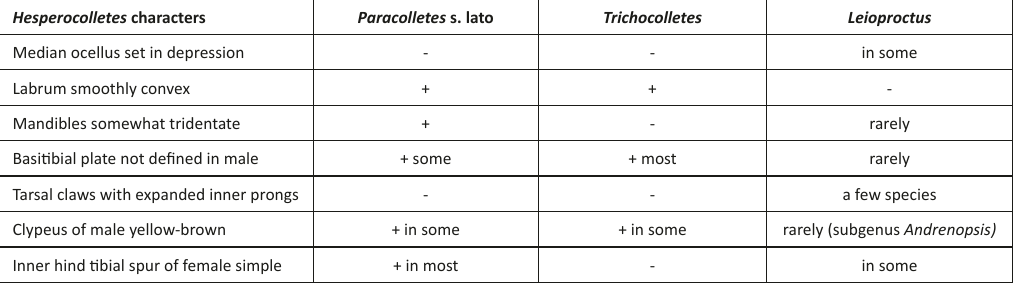
Table 1. Character states shared between Hesperocolletes and three other genera of Paracolletini (N.B.: Paracolletes s. lato includes the subgenus Anthoglossa ). Key: (+): present; (-):